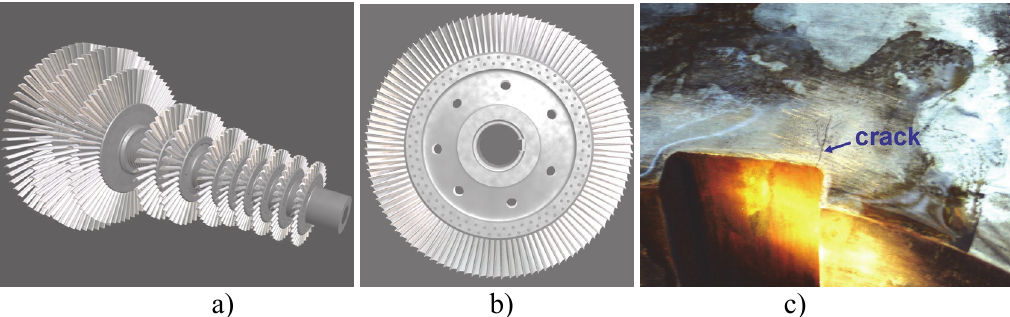
Figure 1: 100 MW steam turbine rotor and disk of 22nd stage with operation damage.